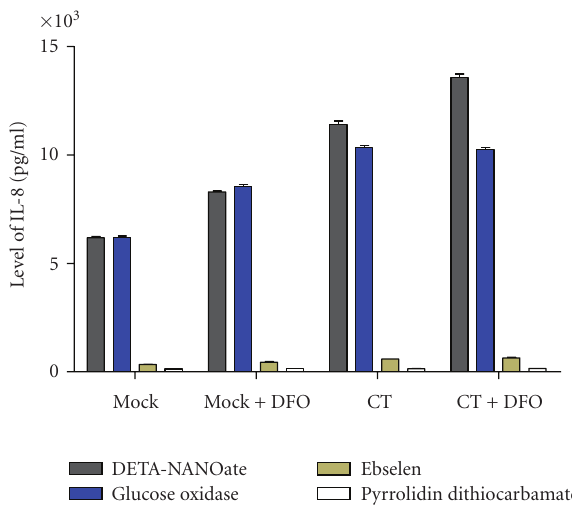
Figure 5: IL-8 induction was significantly ( P < 0 . 001) increased in C. trachomatis infected HeLa cells after stimulation with DETA- NANOate and there was synergic e ff ect with DFO. Glucose oxidase treatment induced IL-8 production at same degree in both the C. trachomatis infected and Mock conditions ( P < 0 . 005). Higher inhibition ( P < 0 . 05) of IL-8 induction was observed after addition of nitric oxide specific inhibitor PDTC than